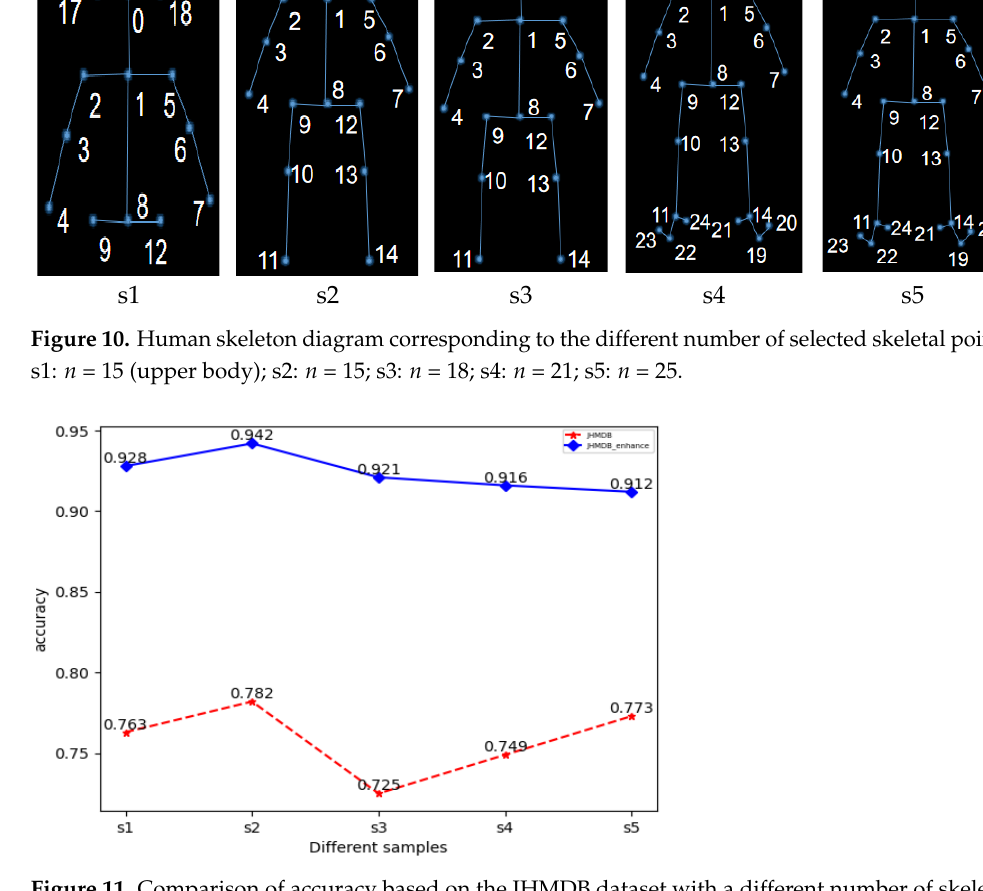
Figure 11. Comparison of accuracy based on the JHMDB dataset with a different number of skeletal points selected. Red is the original dataset; blue is the enhanced dataset after flipping.